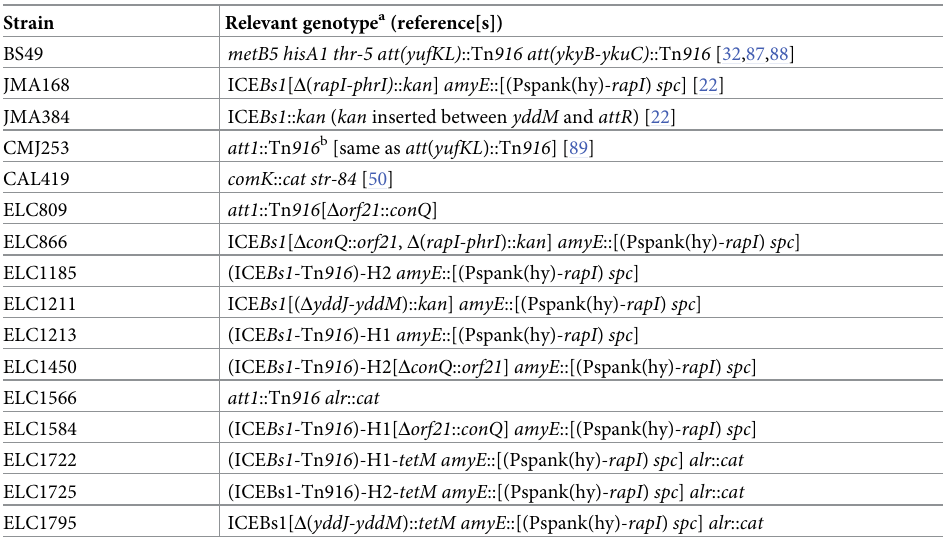
Table 3. Bacillus subtilis strains.